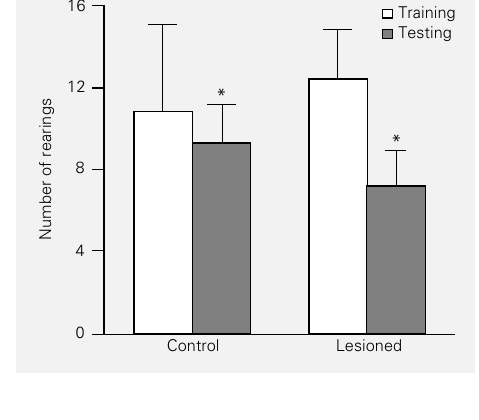
Figure 5 - Effect of a post-train- ing lesion of the entorhinal cor- tex on performance in a two-way active avoidance task. Data are reported as means ± SEM (N = 9 animals/group). *P<0.002 com- pared to the training session (paired Student t -test). **P< 0.001 compared to the control group (unpaired Student t